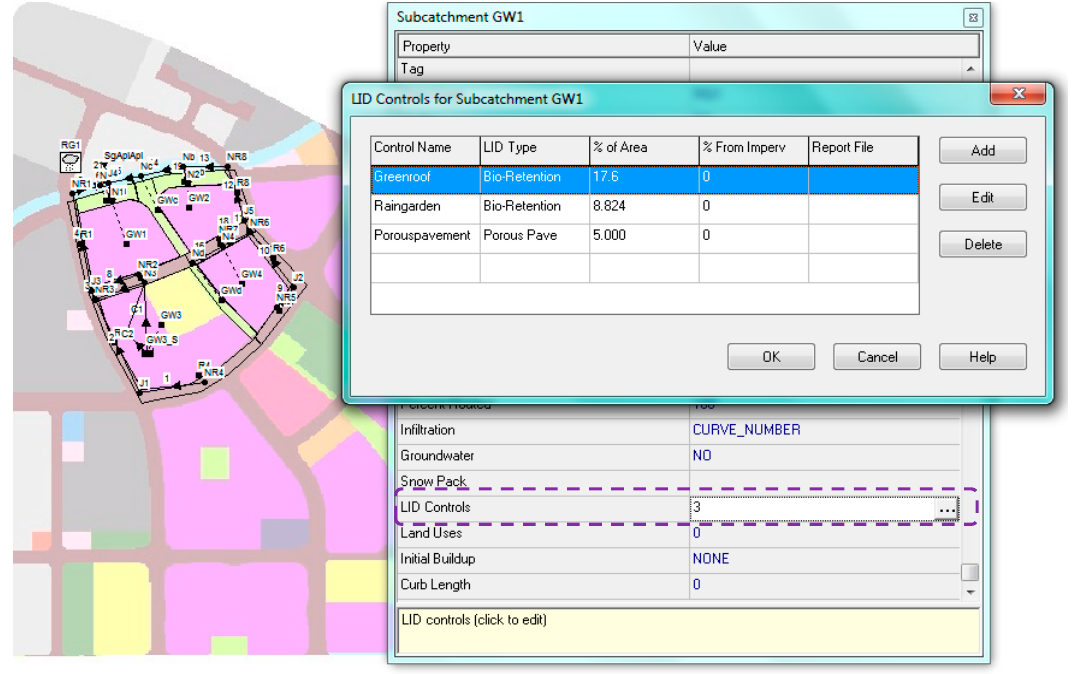
Figure 5. Modelling of low impact development (LID) in SWMM.